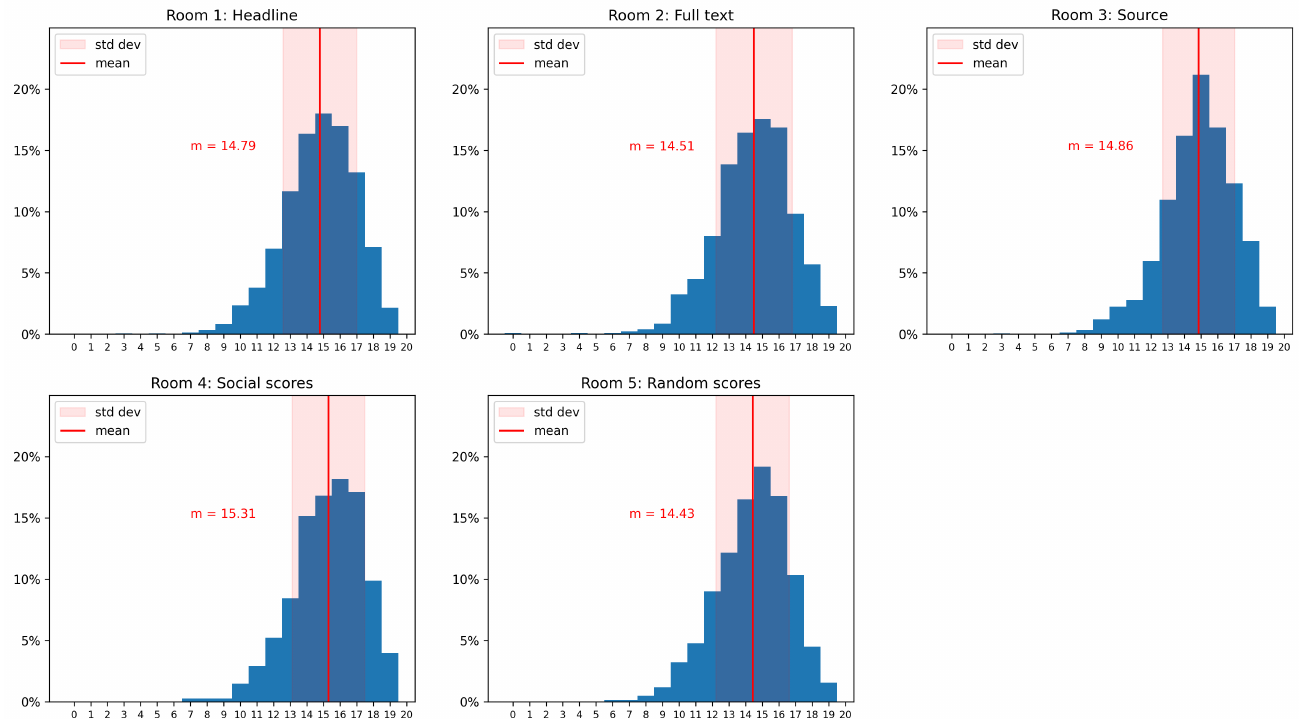
Figure 4. Scores’ distribution by room. Social influence is the feature with the highest posi- tive/negative impact on users’ scores: it can support the reader’s judgement (Room 4), but it can also deceive it (Room